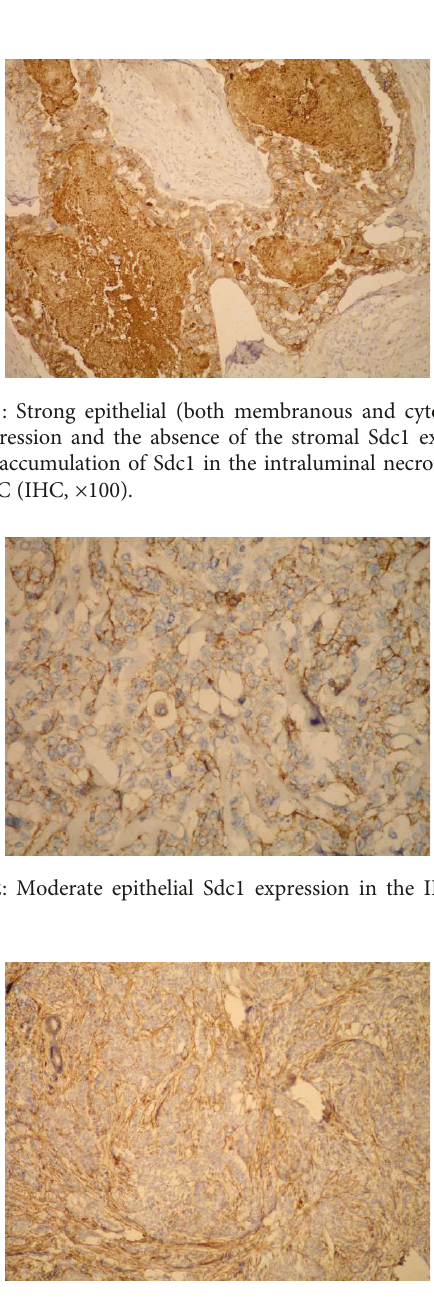
Figure 3: Weak epithelial and strong stromal Sdc1 expression in the ILC (IHC, ×